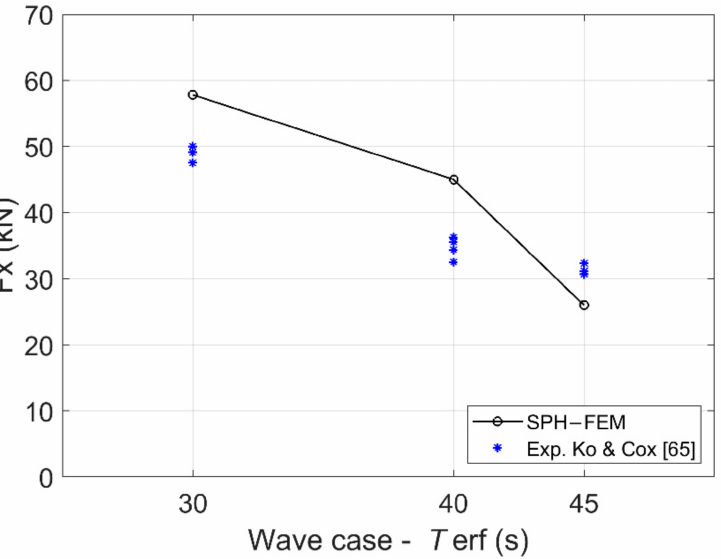
Figure 8. Maximum values of debris impact force on column: experimental tests [65] and numerical simulation for h 1 = 2.496 m, and three wave cases with T erf = 30, 40, and 45